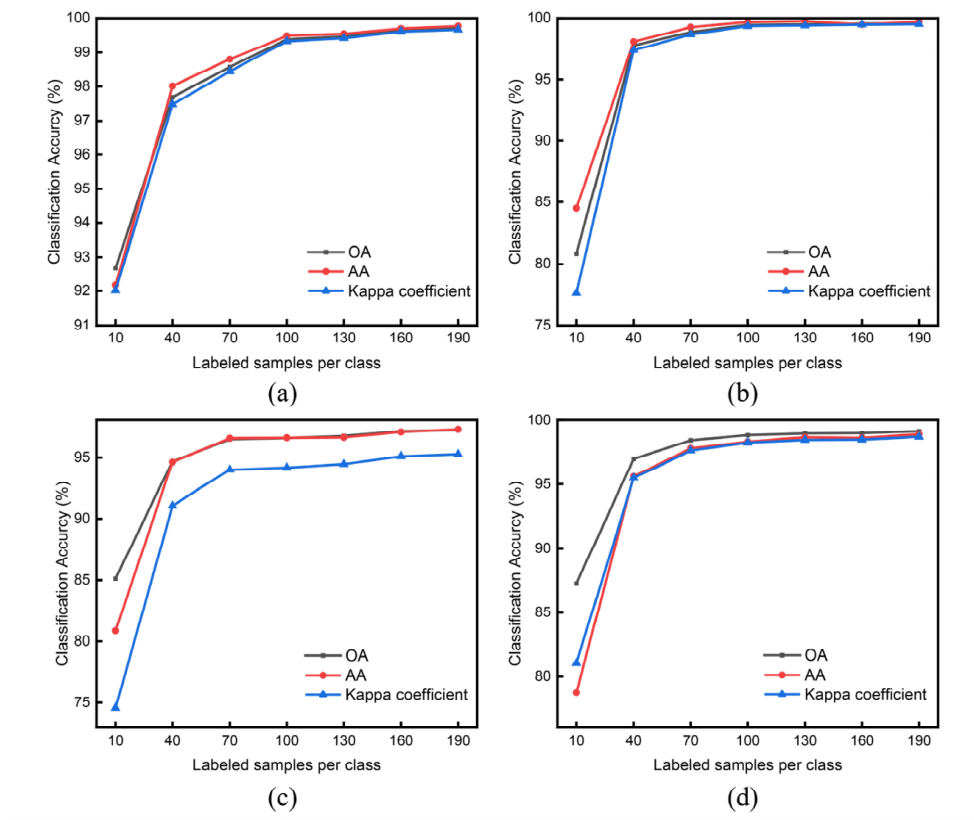
Figure 12. Classification accuracy changes with the number of training samples: ( a ) Flevoland-15 dataset; ( b ) Flevoland-14 dataset; ( c ) Oberpfaffenhofen dataset; ( d ) San Francisco